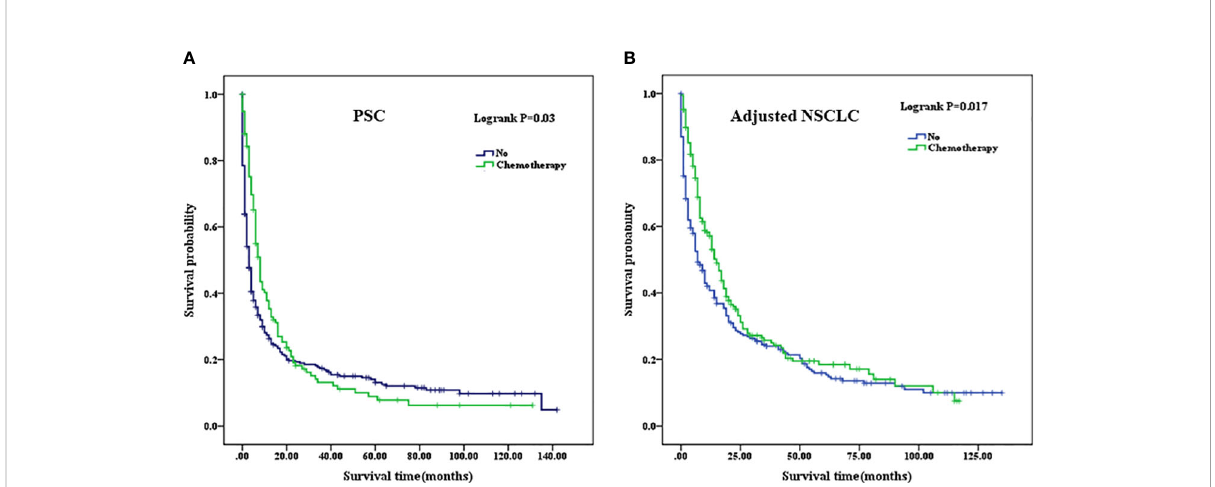
FIGURE 6 (A) Comparison of Kaplan – Meier analysis of survival curves after adjuvant chemotherapy in PSC cohort. (B) Comparison of Kaplan – Meier analysis of survival curves after adjuvant chemotherapy in adjusted NSCLC cohort. PSC, pulmonary sarcomatoid carcinoma; NSCLC, non-small- cell lung